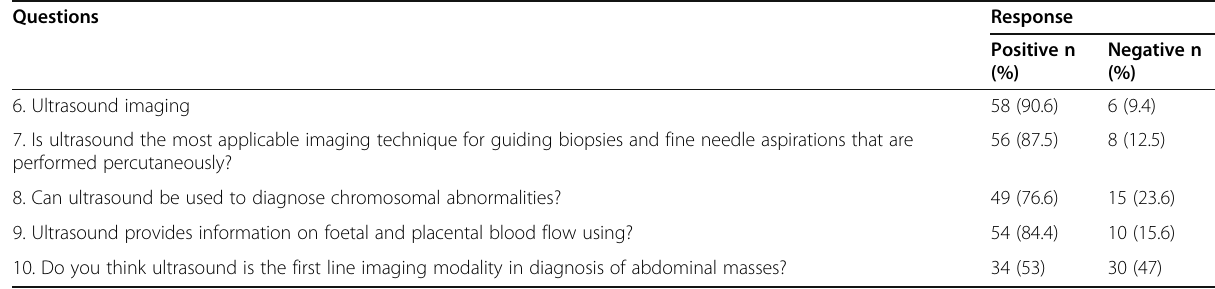
Table 1 Participant response on knowledge of ultrasound and its application in medical diagnosis